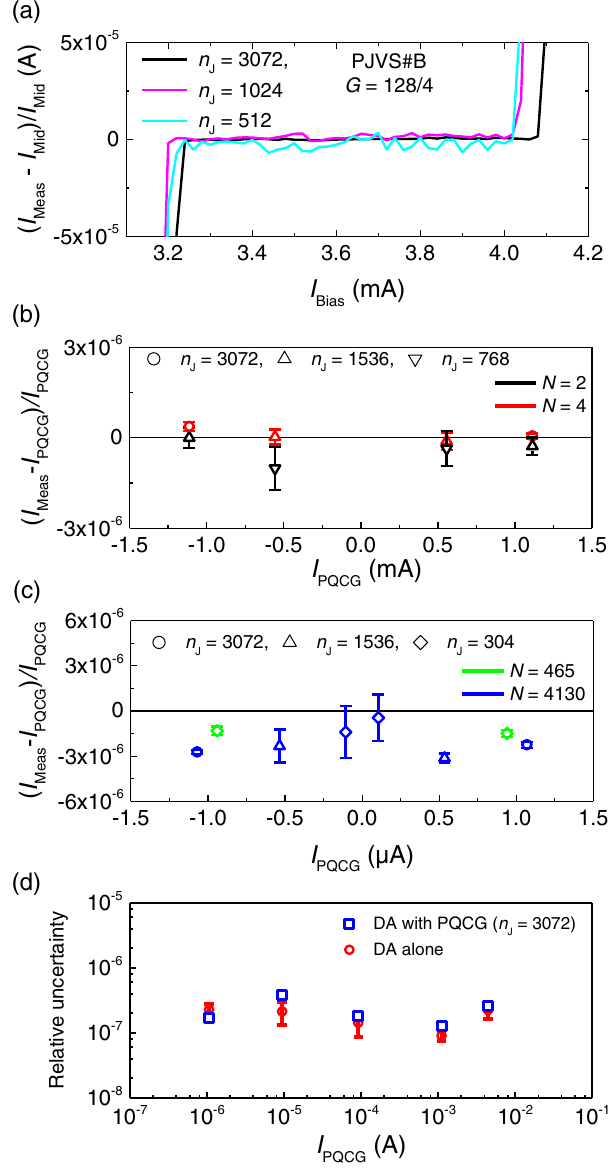
FIG. 4. Calibration of a digital ammeter using the PQCG and identification of quantization criteria. (a) Relative deviation of I [the current generated by the PQCG and measured by the Meas DA (HP3458A)] to I (the current measured at the center of the Mid 3072 , step) as a function of the biasing current I for n Bias J ¼ 1024, and 512 junctions of PJVS#B. The independence of the output current as a function of I is a first quantization criterion. Bias (b) Relative deviation of I to I as a function of I in Meas PQCG PQCG the mA range and (c) in the μ A range. The agreement of = 2 is a second the measurements performed using n and n J J quantization criterion. (d) Relative uncertainty of the measured current (blue squares) and of the DA (open red dots) as a function of I over four decades of current. The DA noise dominates PQCG over that of the PQCG. Error bars are standard uncertainties (1